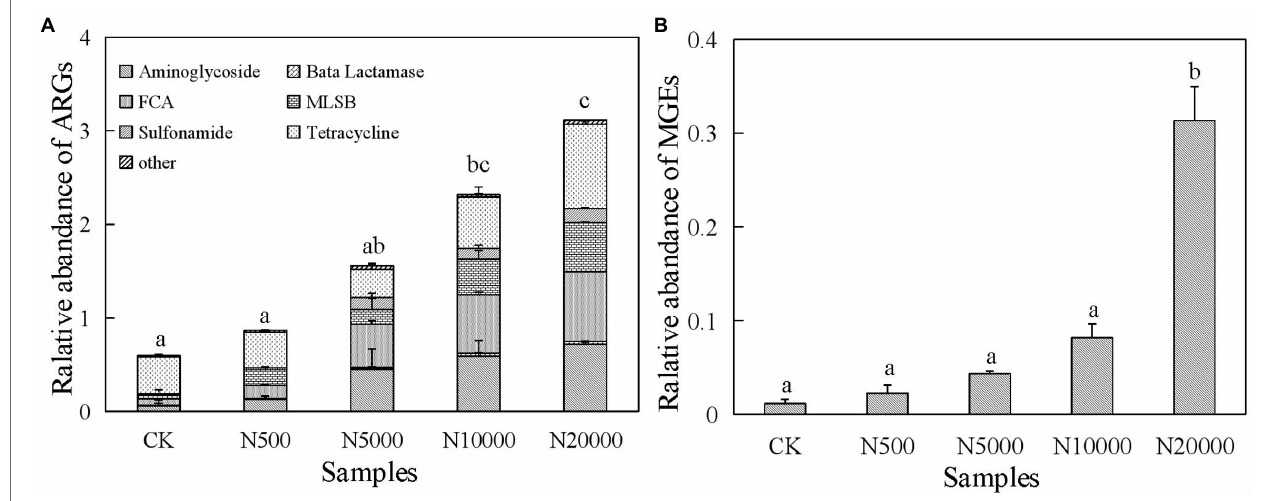
FIGURE 1 | Relative abundance of antibiotic resistance genes (ARGs; A ) and mobile genetic elements (MGEs; B ) in manure samples. Different lowercase letters indicated significant differences (ANOVA, p < 0.05) between manure